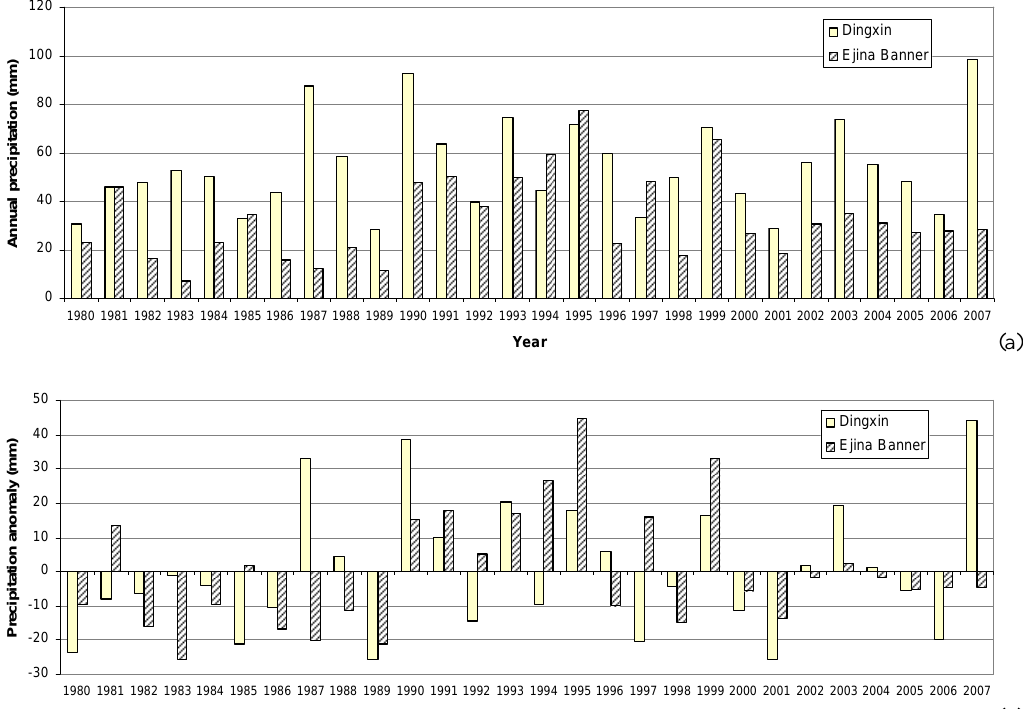
Fig. 4. The annual precipitation at Dingxin and Ejin Banner meteorological stations from 1980 to 2007 (a); The anomaly of the annual precipitations at Dingxin and Ejina Banner meteorological stations from 1980 to 2007 (b).